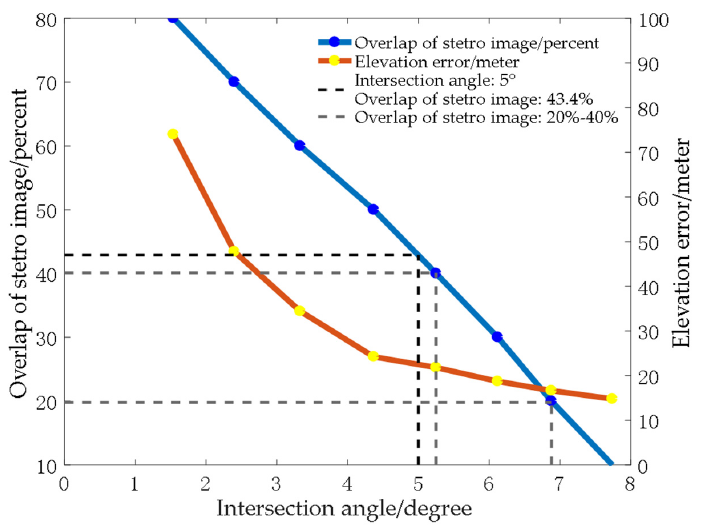
Figure 3. The relationship curve between the image overlaps, elevation error and intersection angle of the GF-6